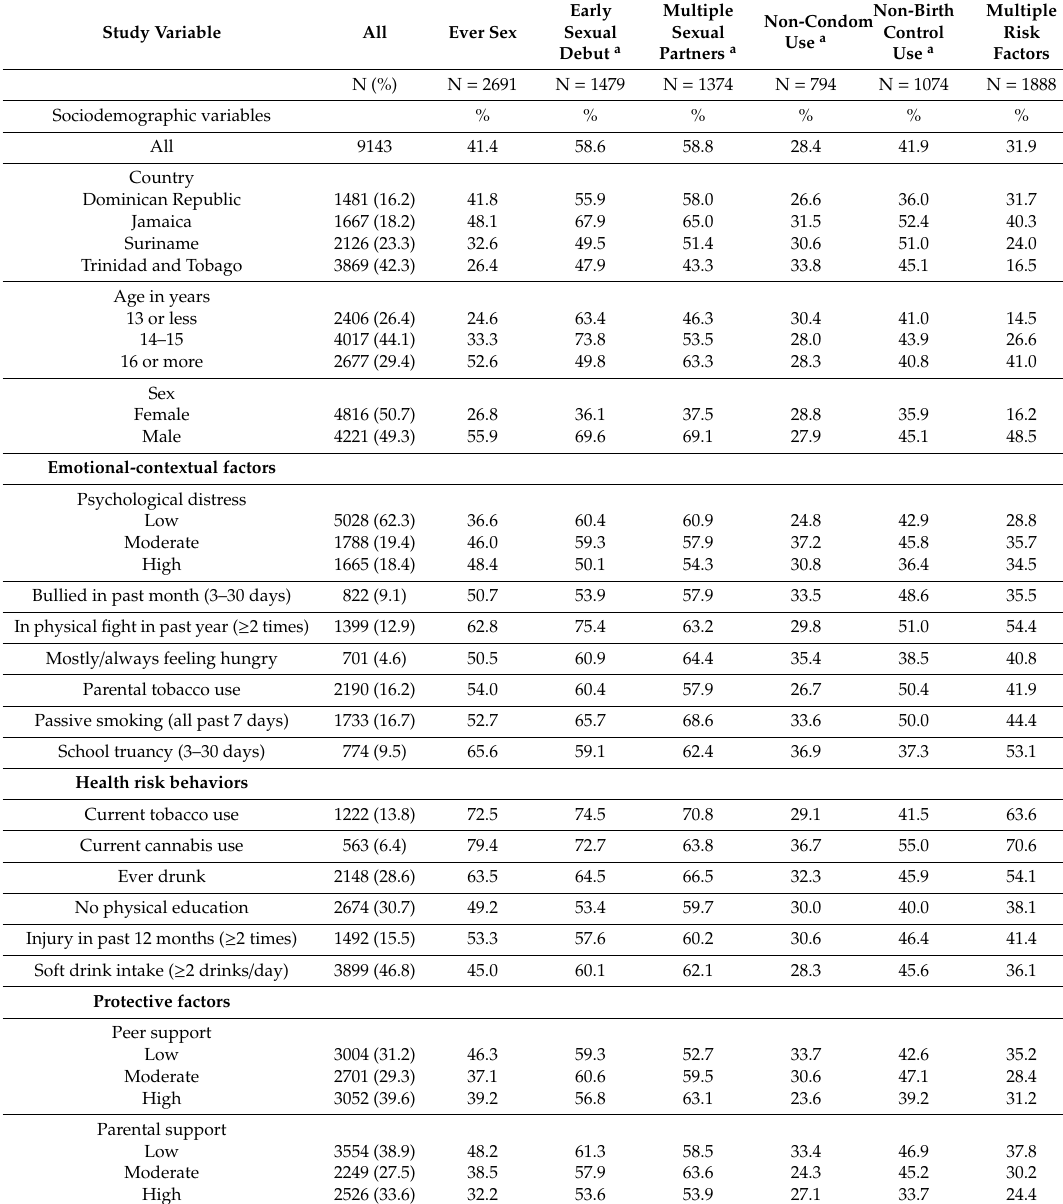
Table 3. Sample characteristics and sexual behavior types among adolescents in four Caribbean countries,